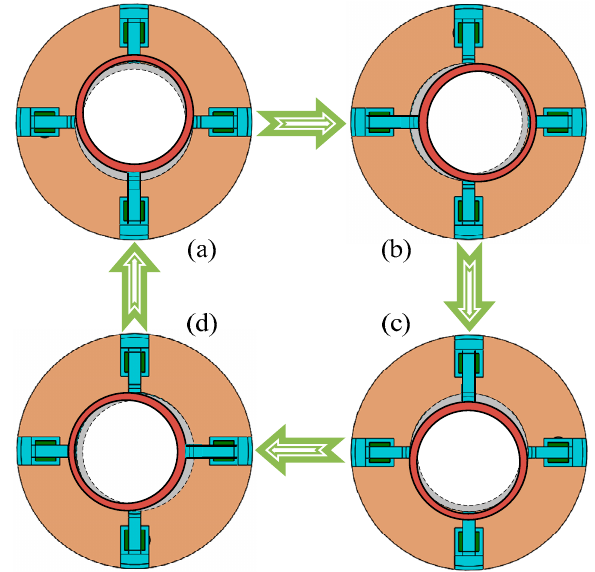
Figure 3. Working principle of the harmonic generator. ( a ) Initial position and 360° position; ( b ) 90° position; ( c ) 180° position; ( d ) 270° position.